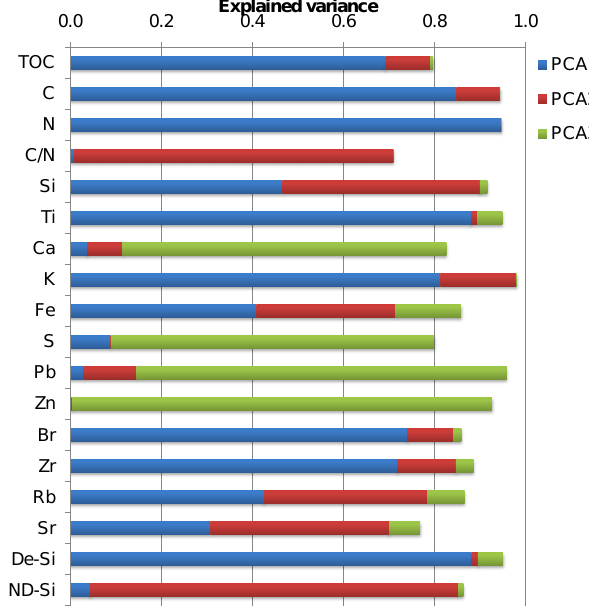
Fig. 5. Explained variance for PCA 1-3 including the geochemistry data and inferred lake-water